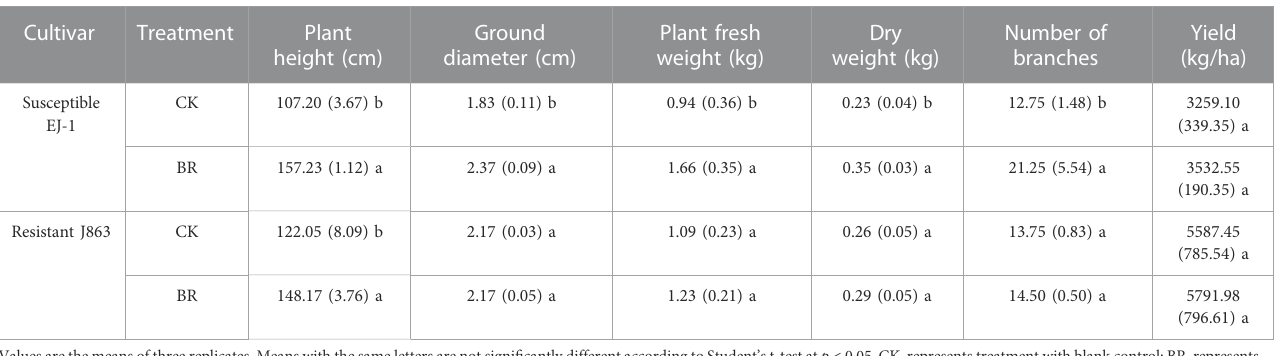
TABLE 1 Effect of BR on cotton growth promotion.